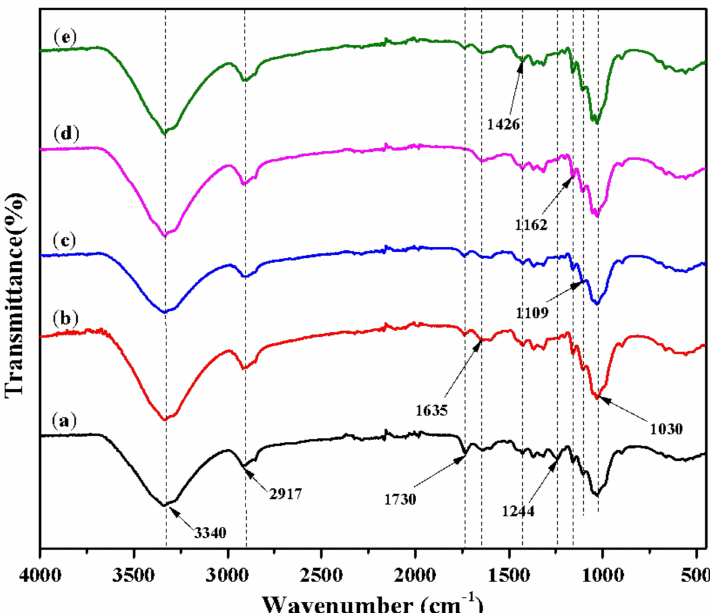
Figure 4. FTIR plot of ( a ) untreated PALF, ( b ) 1, ( c ) 3, ( d ) 6, and ( e ) 9% (wt/wt) NaOH treated PALFs. The bands at ~1244 and ~1730 cm − 1 are affected by